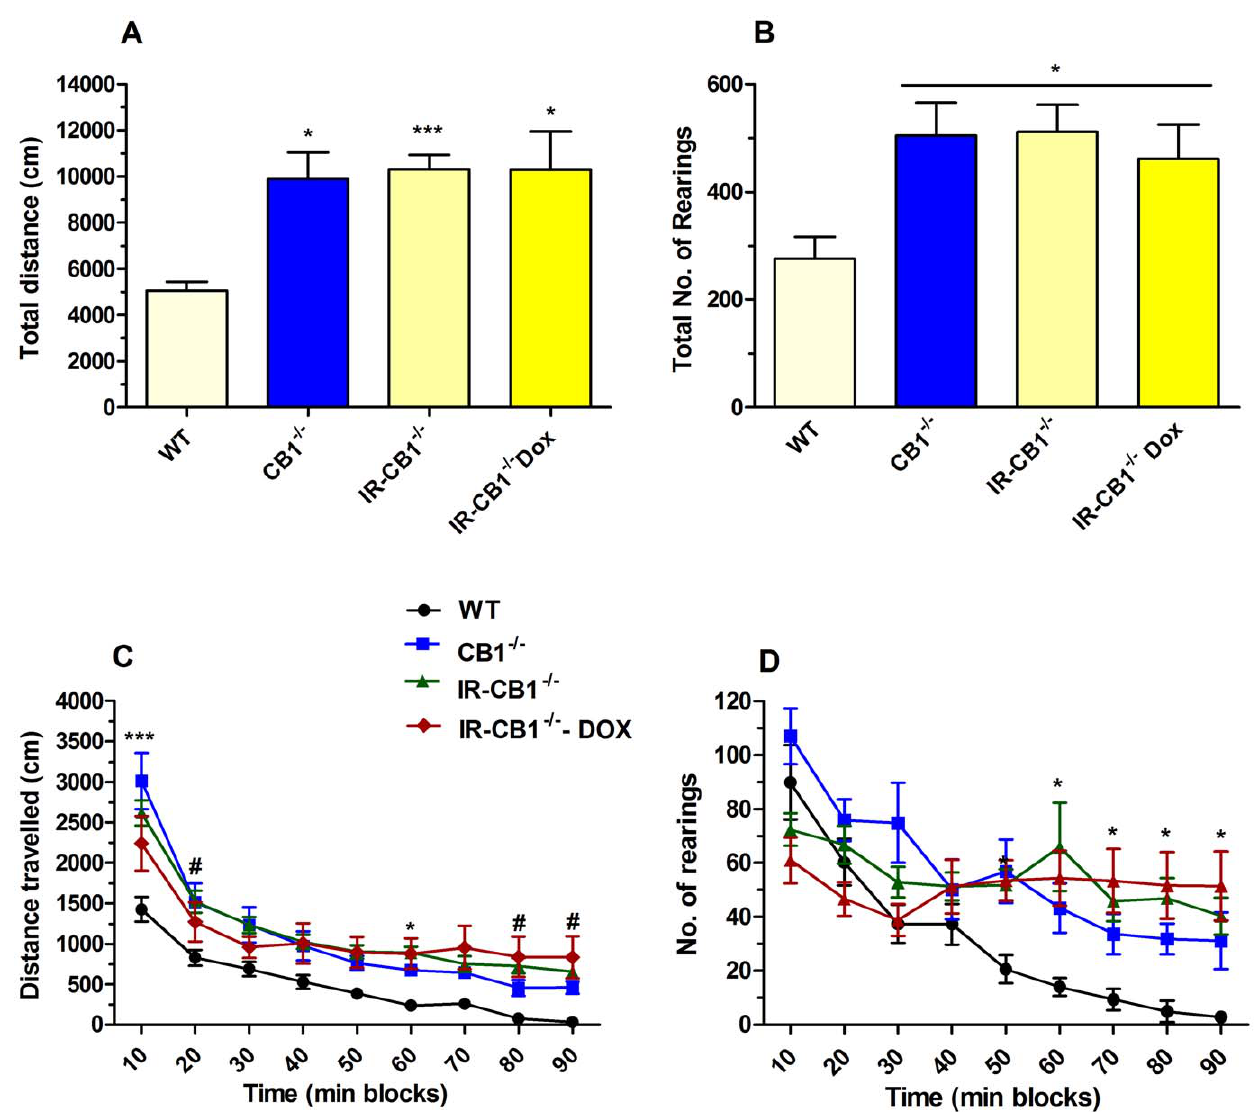
Figure 5. Motor activity in IRh-CB1 -/- , CB1 -/- and WT mice. In panel A and C, the total distance (cm) traveled in 90 min and related time course, respectively, are depicted. The vertical activity expressed as total number of rearing episodes and the time course are illustrated in panel B and D, respectively. All data represent the mean 6 S.E.M. of WT (n=9), CB1 -/- (n=8), IRh-CB1 -/- (n=22) and IRh-CB1 -/- + Dox (n=11) mice. For the rearing behavior for some mice the data have been lost (not recorded by the apparatus) and thus the number of mice for the two latter groups is 18 and 9, respectively. ***P , 0.001 and *P , 0.05 vs WT mice (Dunn’s Multiple Comparison test for total distance, and Newman-Keuls Multiple Comparison test for all the